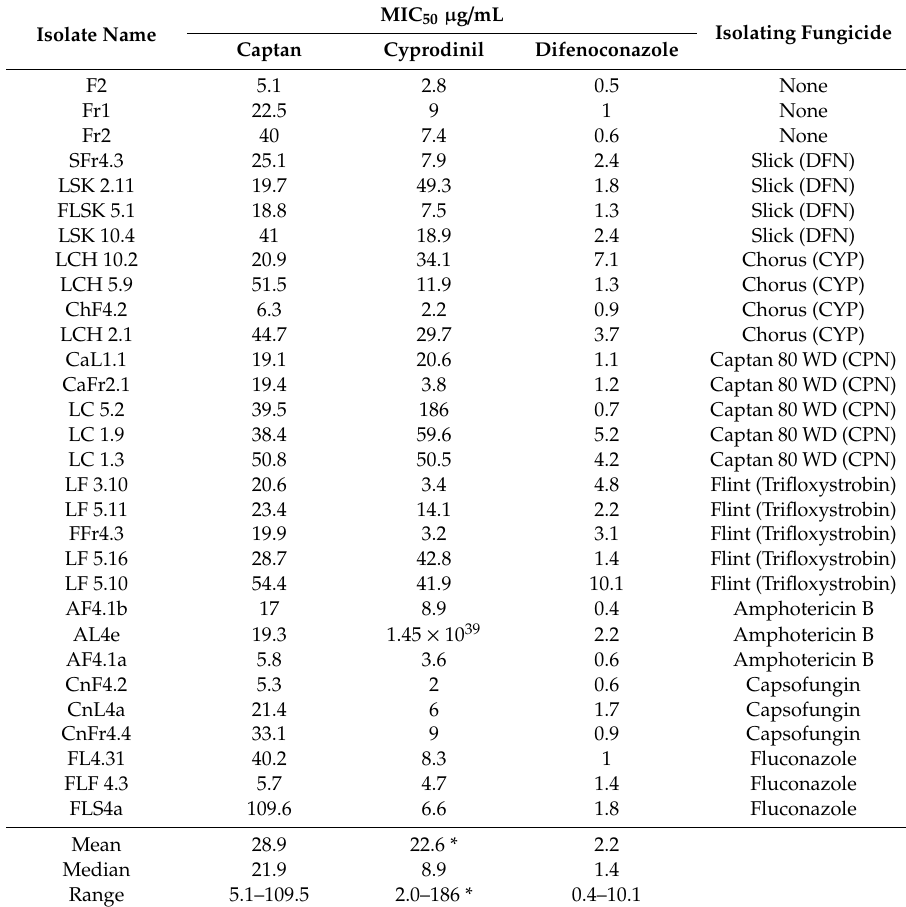
Table 2. Overall MIC 50 mean, median, and range for captan (CPN), cyprodinil (CYP), and DFN for all A. pullulans isolates.